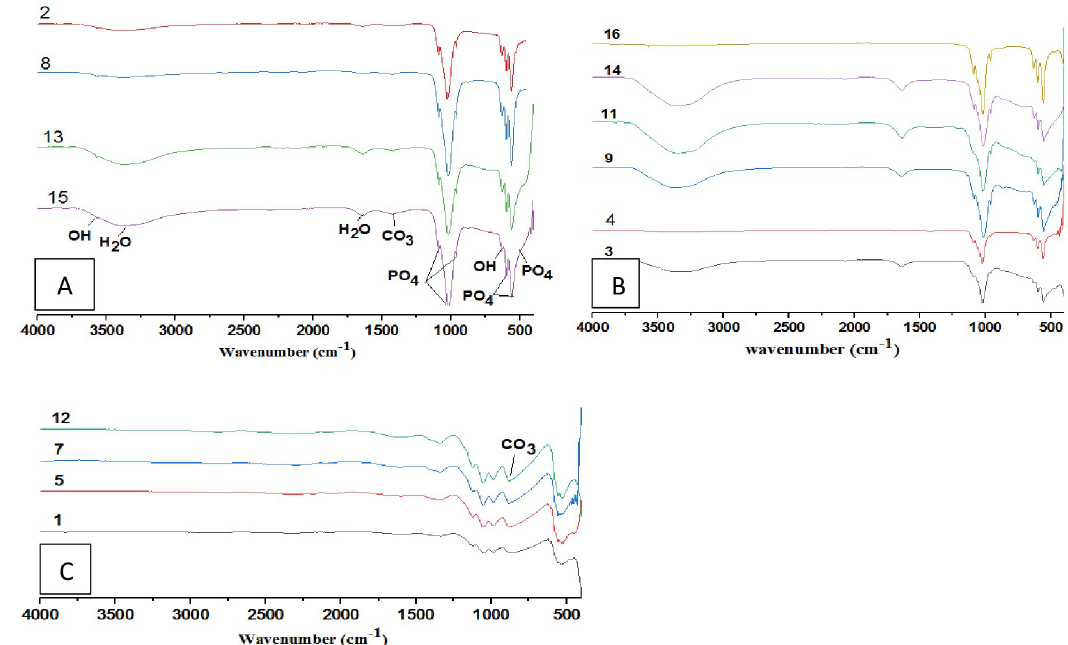
Fig 1. FTIR spectra of HAp powders at different condition based on RSM design. A) Alkaline condition; B) Normal condition; C) Acidic